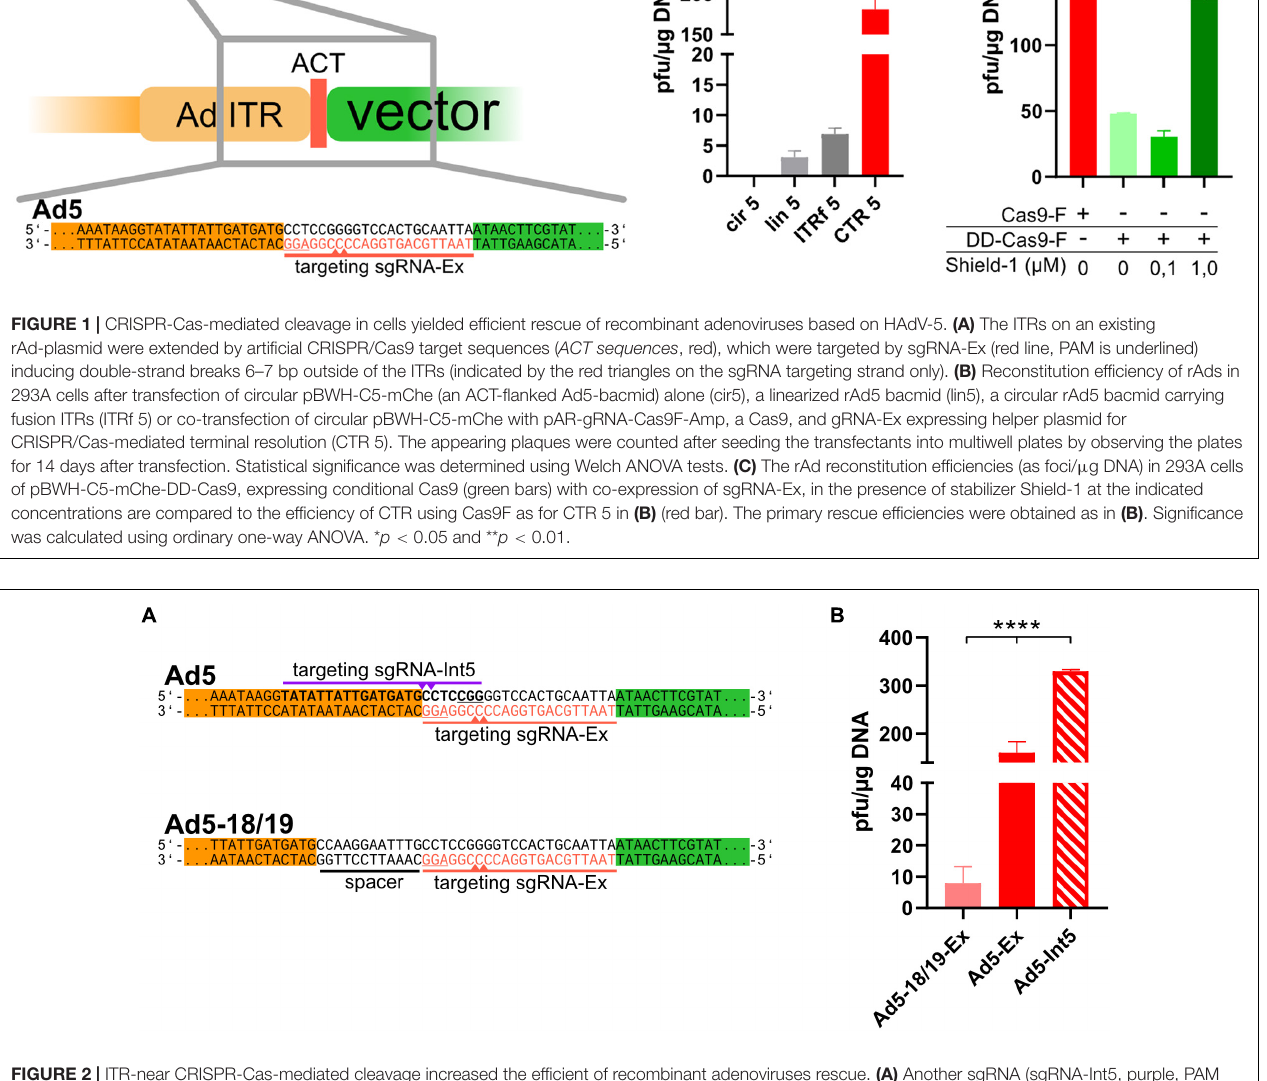
FIGURE 2 | ITR-near CRISPR-Cas-mediated cleavage increased the efficient of recombinant adenoviruses rescue. (A) Another sgRNA (sgRNA-Int5, purple, PAM underlined) targeting the ITRs (bold) can induce Cas9-mediated cleavage at the ITRs (purple triangles). To check the impact of cleavage distance, the ITRs were extended by CRISPR/Cas9 target sequences ( ACT , red) using a 12-bp long spacer (black underlined), which was targeted by sgRNA-Ex (red, PAM is underlined) inducing double-strand breaks (red triangles) 18–19 bp upstream of the ITRs. (B) rAd reconstitution efficiencies were compared after co-transfection of 293A cells with pBWH-C5-mChe and pSG5-Cas9F in the presence of either sgRNA-Int5 (Ad5-Int5) or sgRNA-Ex (Ad5-Ex), and with pBWH18/19-C5-mChe in the presence of sgRNA-Ex (Ad518/19-Ex). The primary rescue efficiencies were obtained as in Figure 1B . Significance was calculated using Welch ANOVA test. **** p <